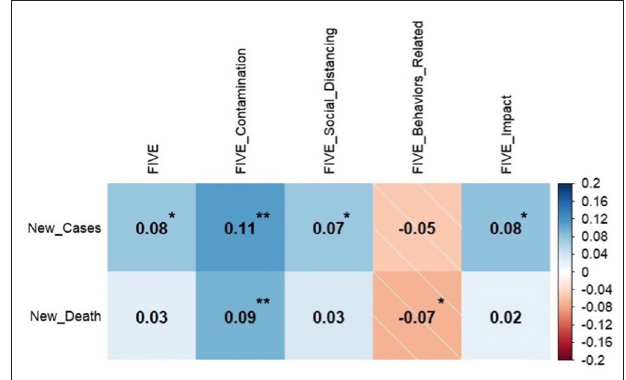
FIGURE 1 | Correlation between the number of confirmed cases and death due to COVID-19 and fear of illness and virus evaluation ( N = 983, * p < 0.05, ** p <